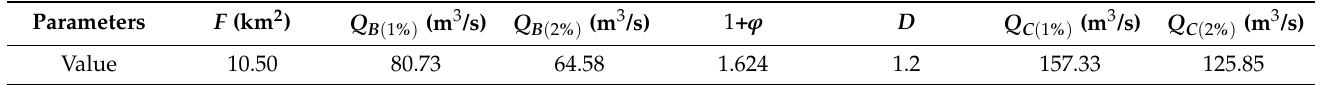
Table 2. Key values concerning the discharge of the Boshuigou debris flow under different return- period